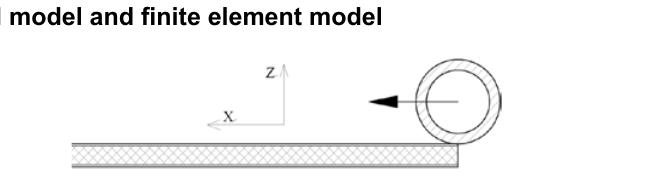
Fig. 3. Schematic diagram of the honeycomb sandwich structure in the cylinder peel strength test.